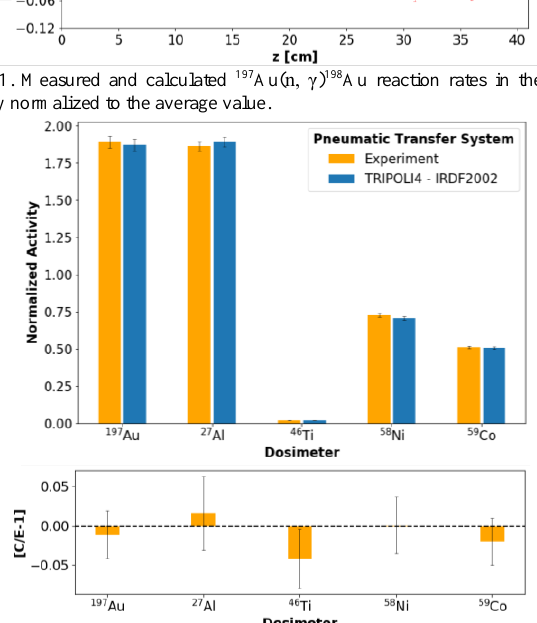
Fig. 12. Measured and calculated reaction rates in the PTS normalized to the 197 Au(n, γ) 198 Au reaction rates in the core